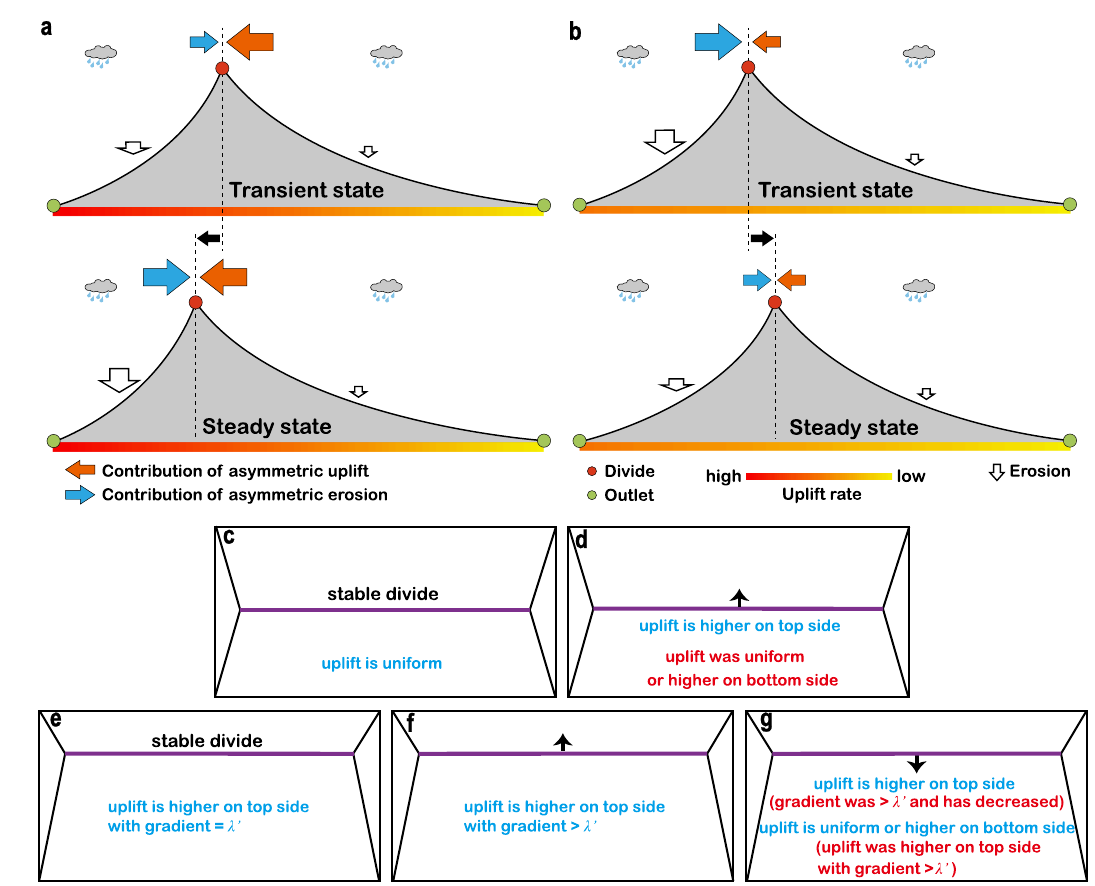
Fig. 4 Divide migration in response to asymmetric uplift and erosion, and its implications for constraining tectonic information. a When asymmetric uplift dominates divide mobility, divide moves to the side with a higher uplift rate until it reaches steady state. b When erosional contrast predominantly in fl uences divide mobility, divide migrates to the side with a lower erosion rate to reach equilibrium. c Symmetric mountain belt with a stable divide. d Symmetric mountain belt with an unstable divide. e Asymmetric mountain belt with a stable divide. f Asymmetric mountain belt with a divide that is migrating to the steeper side. g, Asymmetric mountain belt with a divide that is moving to the gentler-sloping side. Purple lines are the divide, with its direction of motion marked by arrows. Constraints on present uplift and its history are given in the blue and red comments,